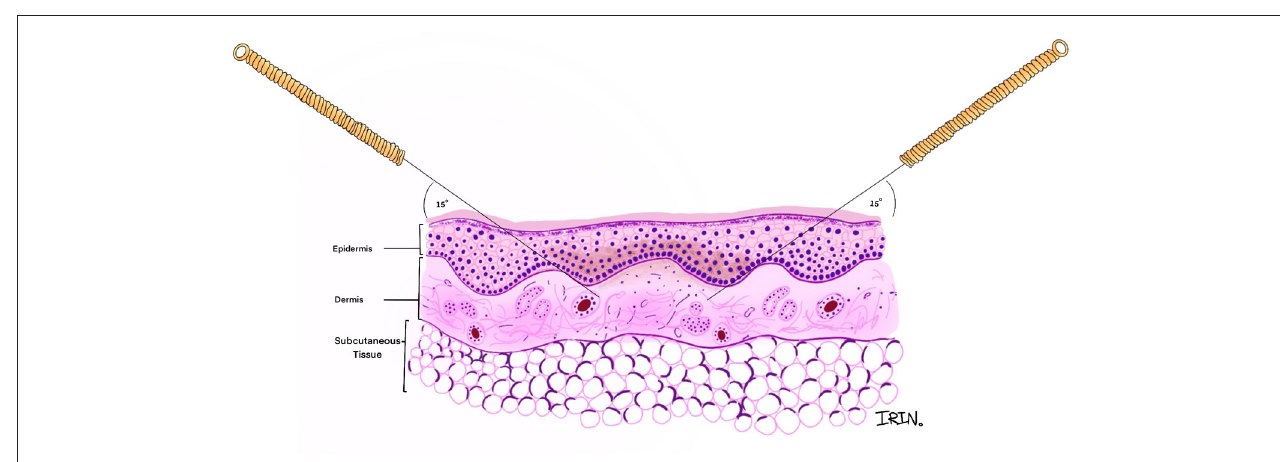
FIGURE 2 | Cross-sectional view of angle and direction of the encircle acupuncture.